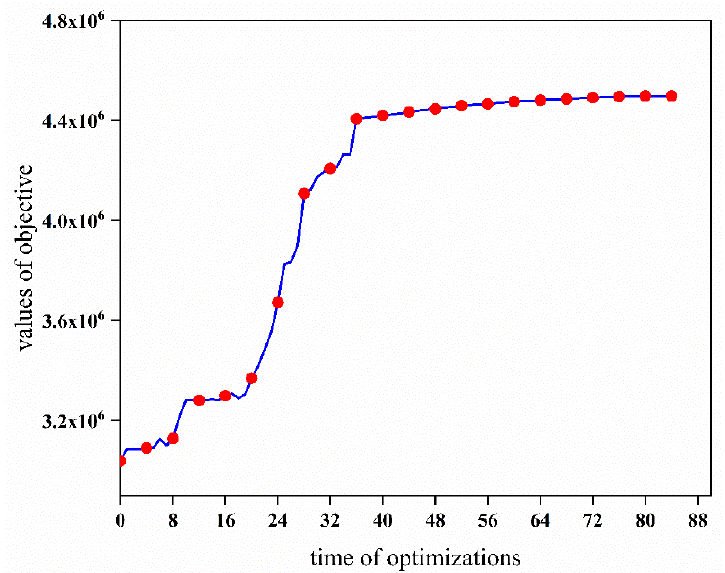
Figure 4. Converging process of the